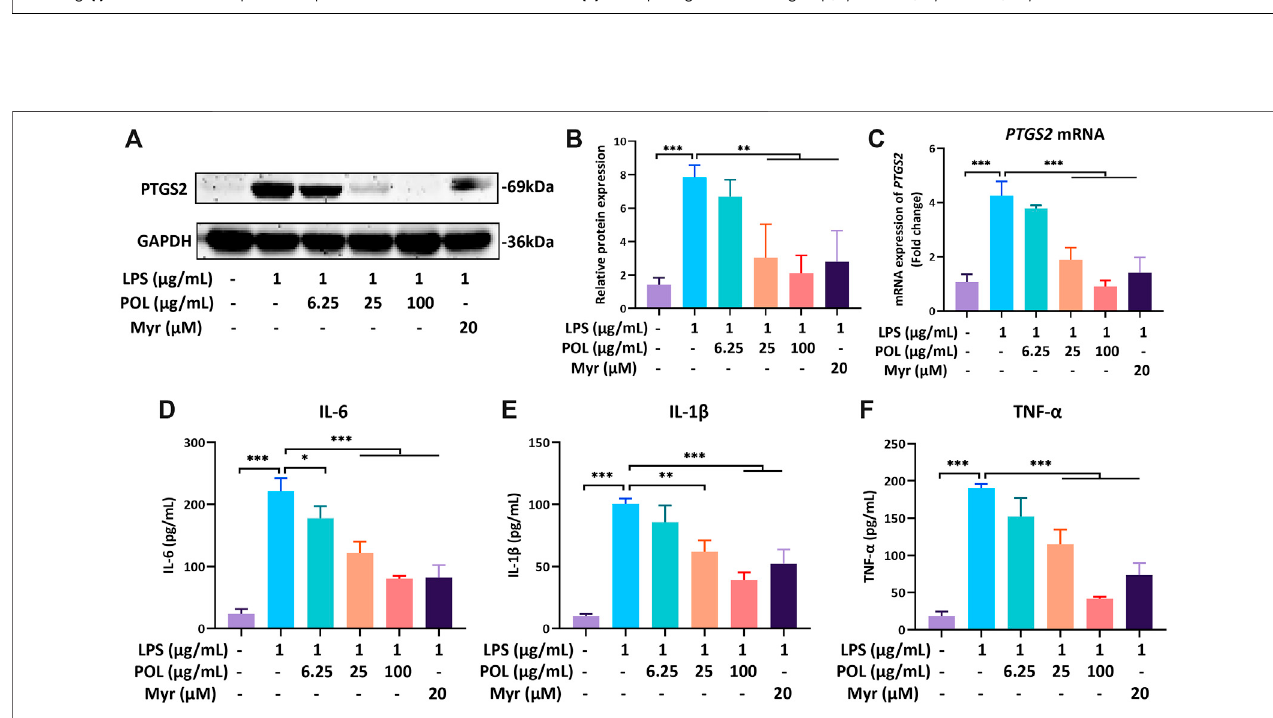
FIGURE 9 | The effects of POL and Myr on protein and mRNA expression of PTGS2 and the secretion of IL-6, IL-1 β , and TNF- α in LPS-induced RAW264.7. RAW264.7 was incubated with 1 μ g/ml LPS and treated with 6.25, 25, and 100 μ g/ml POL and 20 μ M Myr for 18 h. Then, the protein expression (A) and mRNA expression of PTGS2 (C) were detected and the relative protein expression was calculated (B) . The cells were pretreated with 6.25, 25, and 100 μ g/ml POL and 20 μ M Myr for 1 h and exposed to 1 μ g/ml LPS for 18 h. Then, the levels of IL-6 (D) , IL-1 β (E) , and TNF- α (F) in culture supernatant were determined by ELISA. Comparing with model group, * P < 0.05, ** P < 0.01, *** p < 0.001.